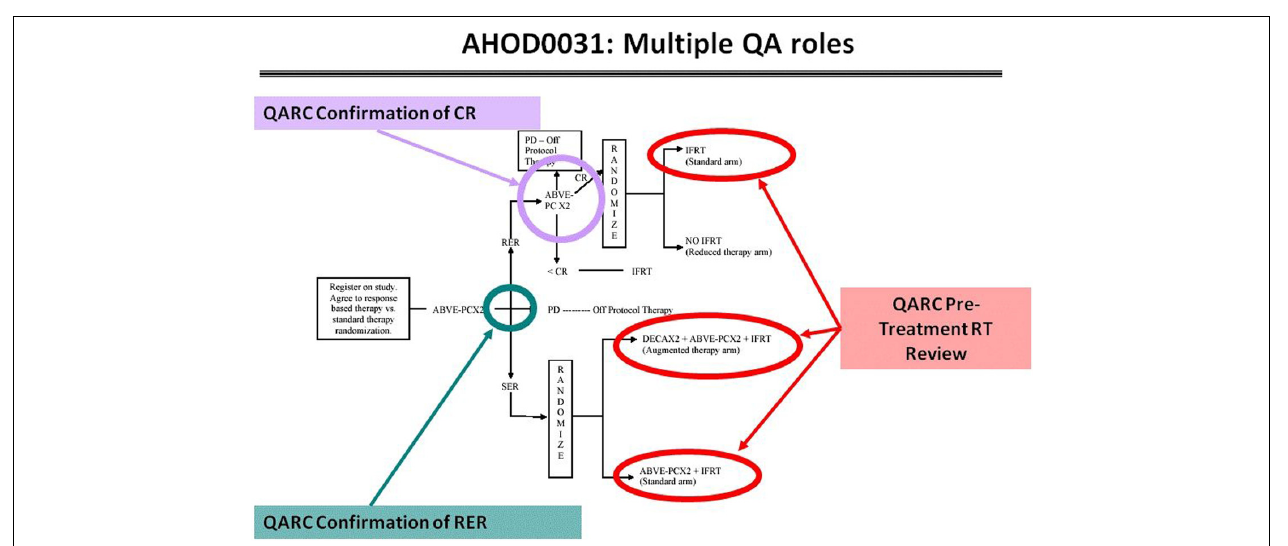
FIGURE 6 | Real-time review points in